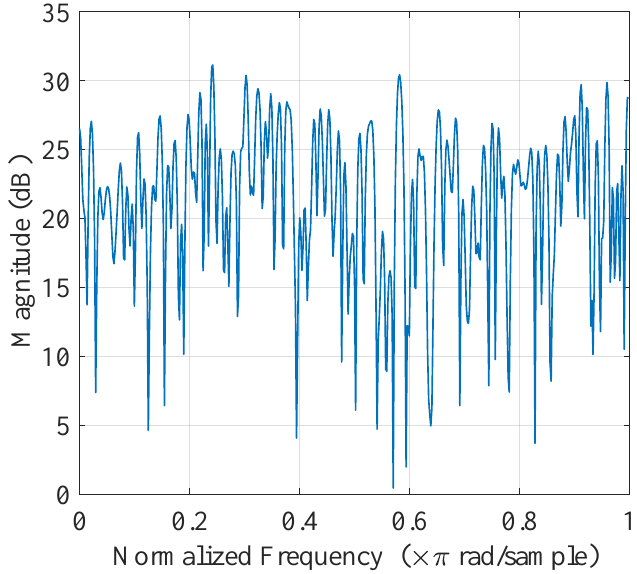
Figure 1. PLC channel frequency